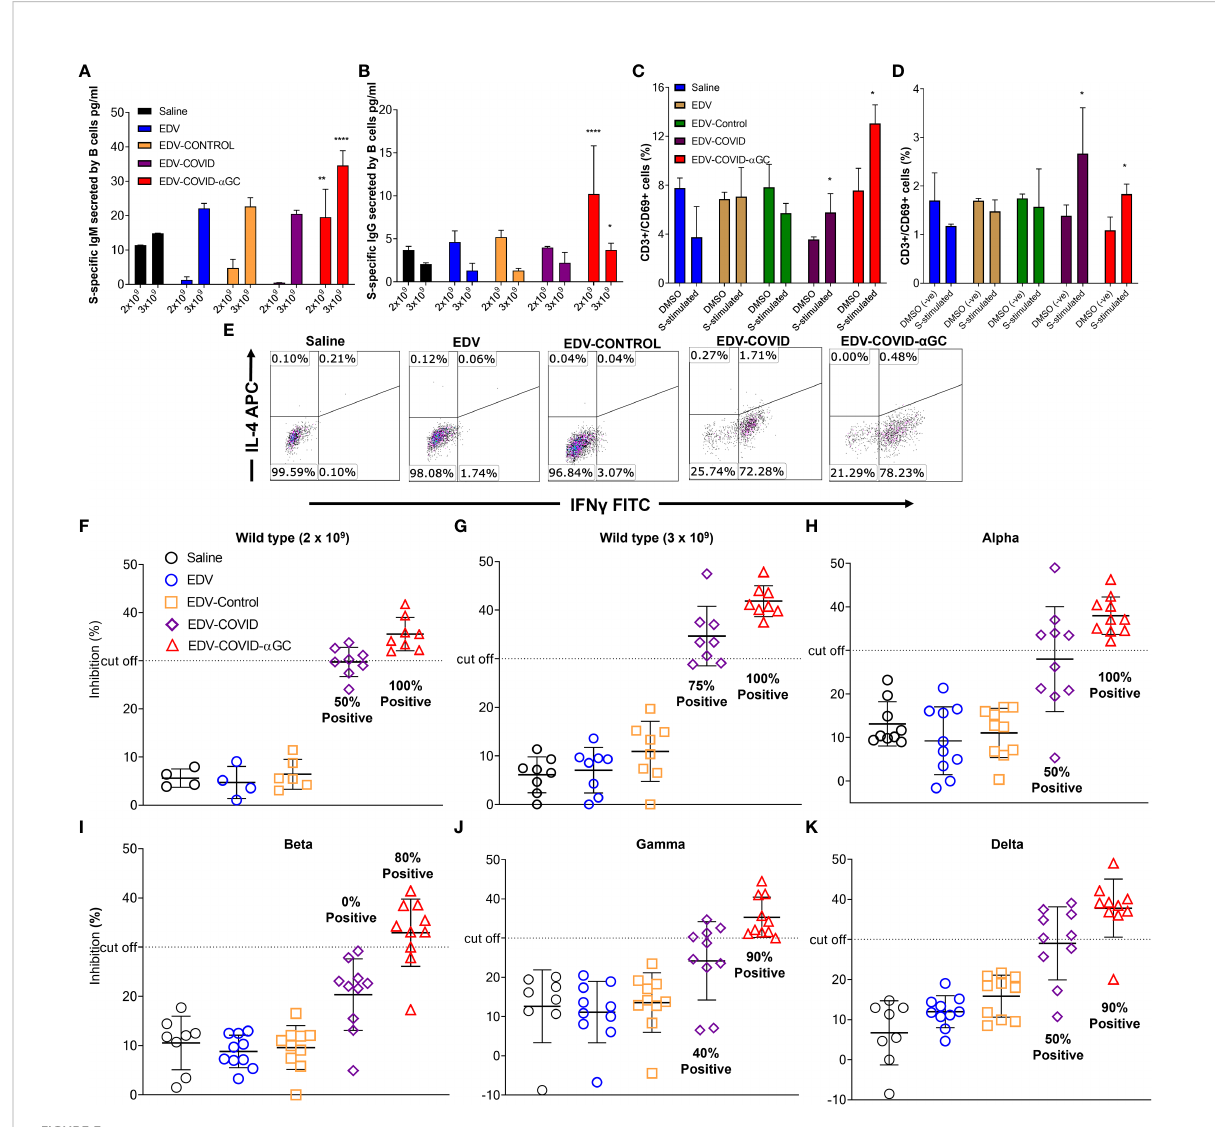
FIGURE 3 S-protein-speci fi c B and T cell response in murine bone marrow derived B cells and splenocytes and Surrogate Viral Neutralization Test (sVNT) on mouse serum from female Balb/c mice dosed on day 1 and boosted on day 21. S-protein speci fi c IgG and IgM production from bone marrow derived B cells isolated from 2 x 10 9 and 3 x 10 9 treated mice (n = 6) at day 28 post-initial dose following ex-vivo stimulation with SARS-CoV-2 S- protein. (A) IgM (pg/ml) concentrations in 2 x 10 9 dose groups and 3 x 10 9 dose groups. (B) IgG (pg/ml) concentrations in 2 x 10 9 dose groups and 3 x 10 9 dose groups. (C) Change in CD69 expression within the CD8 + cytotoxic T cell population following the stimulation of ex vivo splenocytes with wild type SARS-CoV-2 S-protein in the 2 x 10 9 dose groups and (D) 3 x 10 9 dose groups compared to DMSO (negative) stimulated controls. Data presented as mean ± SEM. Asterisks represent signi fi cant values (**** p ≤ 0.0001; ** p ≤ 0.01; * p ≤ 0.05) calculated using one way ANOVA on GraphPad Prism v 9.4.0. (E) IFN g (Th1) and IL-4 (Th2) expression within the CD3 + CD4 + T cell population in SARS-CoV-2 S-protein stimulated ex vivo splenocytes. (F – K) Viral neutralization tests (VNTs) using the cPASS ™ SARS-CoV-2 Neutralizing Antibody Assay (FDA approved) for detection in various species was used to assess inhibition of RBD binding to hACE2 receptor. (F) VNTs using the serum of mice immunized with 2 x 10 9 (n = 4, 8) and (G) 3 x 10 9 (n = 8) EDVs against SARS-CoV-2 RBD wild-type. Subsequent VNTs were conducted using the serum of 3 x 10 9 EDV immunized mice against the Alpha (H) , Beta (I) , Gamma (J) and Delta (K) variant RBDs (n = 8). Dotted line represents sVNT 30% cut-off correlating with a positive PRNT90 for 1:10 dilution of